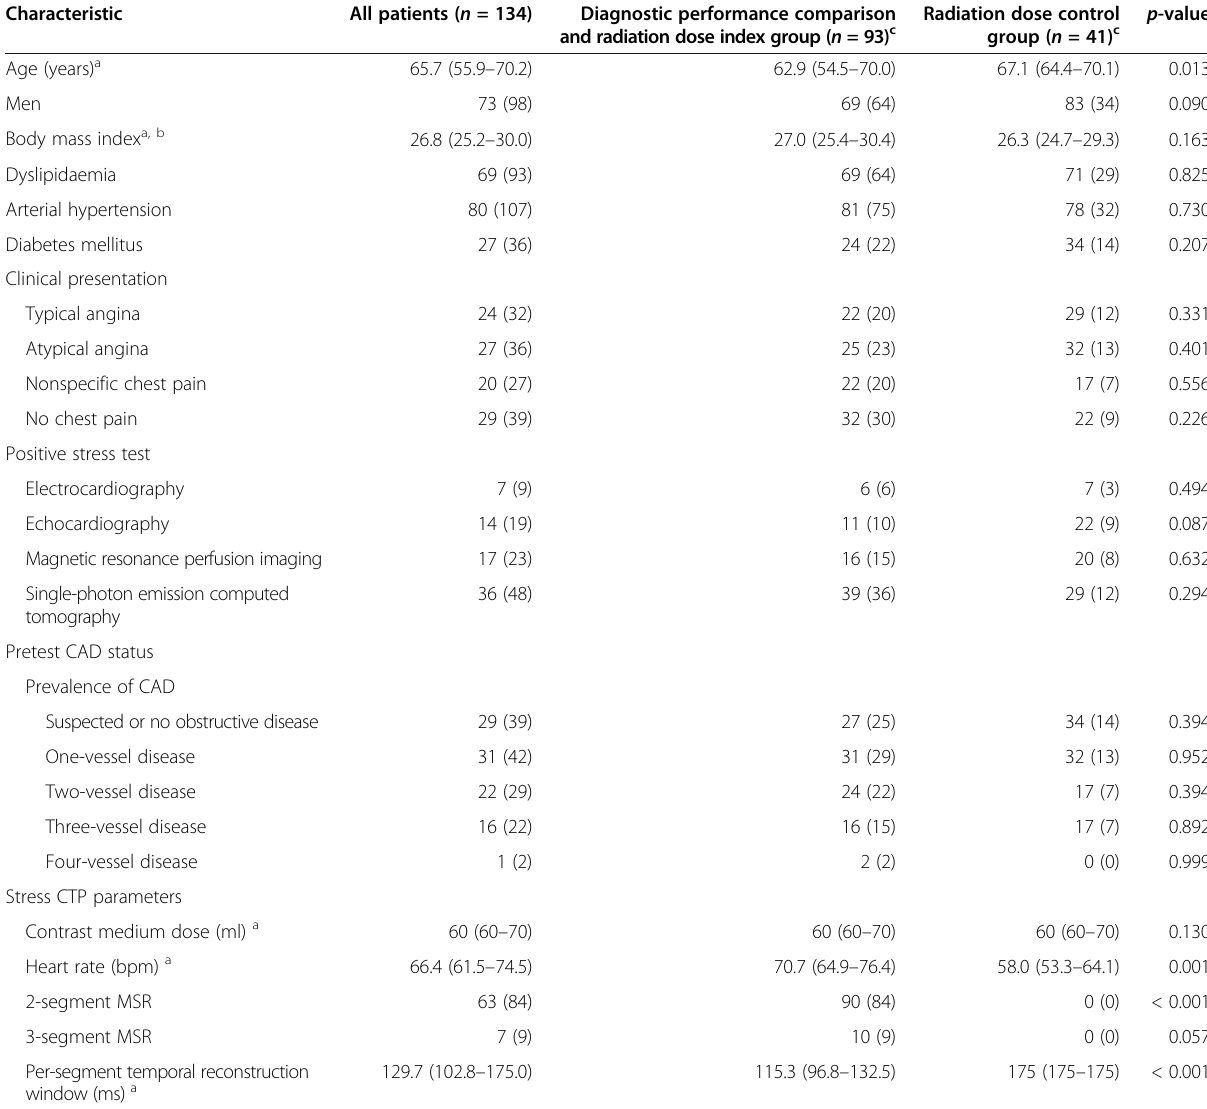
Table 2 Characteristics of the 134 patients analysed in this study Characteristic All patients ( n = 134) Diagnostic performance comparison and radiation dose index group ( n = 93)